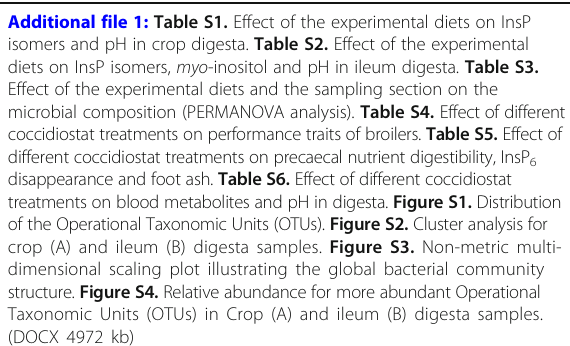
Additional file 1: Table S1. Effect of the experimental diets on InsP isomers and pH in crop digesta. Table S2. Effect of the experimental diets on InsP isomers, myo -inositol and pH in ileum digesta. Table S3. Effect of the experimental diets and the sampling section on the microbial composition (PERMANOVA analysis). Table S4. Effect of different coccidiostat treatments on performance traits of broilers. Table S5. Effect of different coccidiostat treatments on precaecal nutrient digestibility, InsP 6 disappearance and foot ash. Table S6. Effect of different coccidiostat treatments on blood metabolites and pH in digesta. Figure S1. Distribution of the Operational Taxonomic Units (OTUs). Figure S2. Cluster analysis for crop (A) and ileum (B) digesta samples. Figure S3. Non-metric multi- dimensional scaling plot illustrating the global bacterial community structure. Figure S4. Relative abundance for more abundant Operational Taxonomic Units (OTUs) in Crop (A) and ileum (B) digesta samples. (DOCX 4972 kb) Abbreviations ADFI: Average daily feed intake; ADG: Average daily gain; ANOVA: Analysis of variance; BW: Bodyweight; Ca: Calcium; Coc: Coccidiostat; CP: Crude